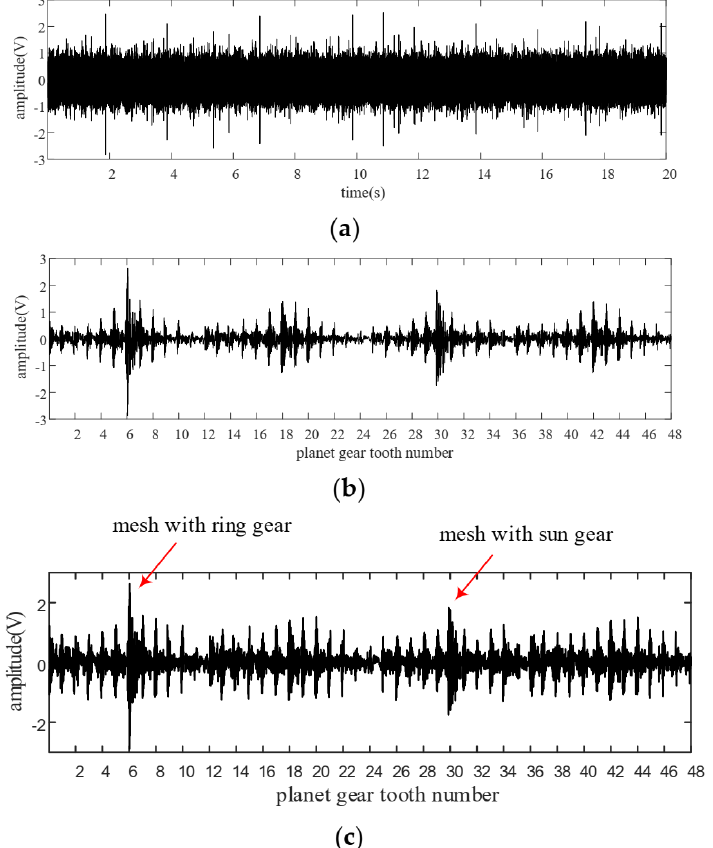
Figure 13. Signal analysis results with pitting fault on planet gear: ( a ) vibration signal, ( b ) multi-teeth VS waveform, ( c ) TVTF-VS